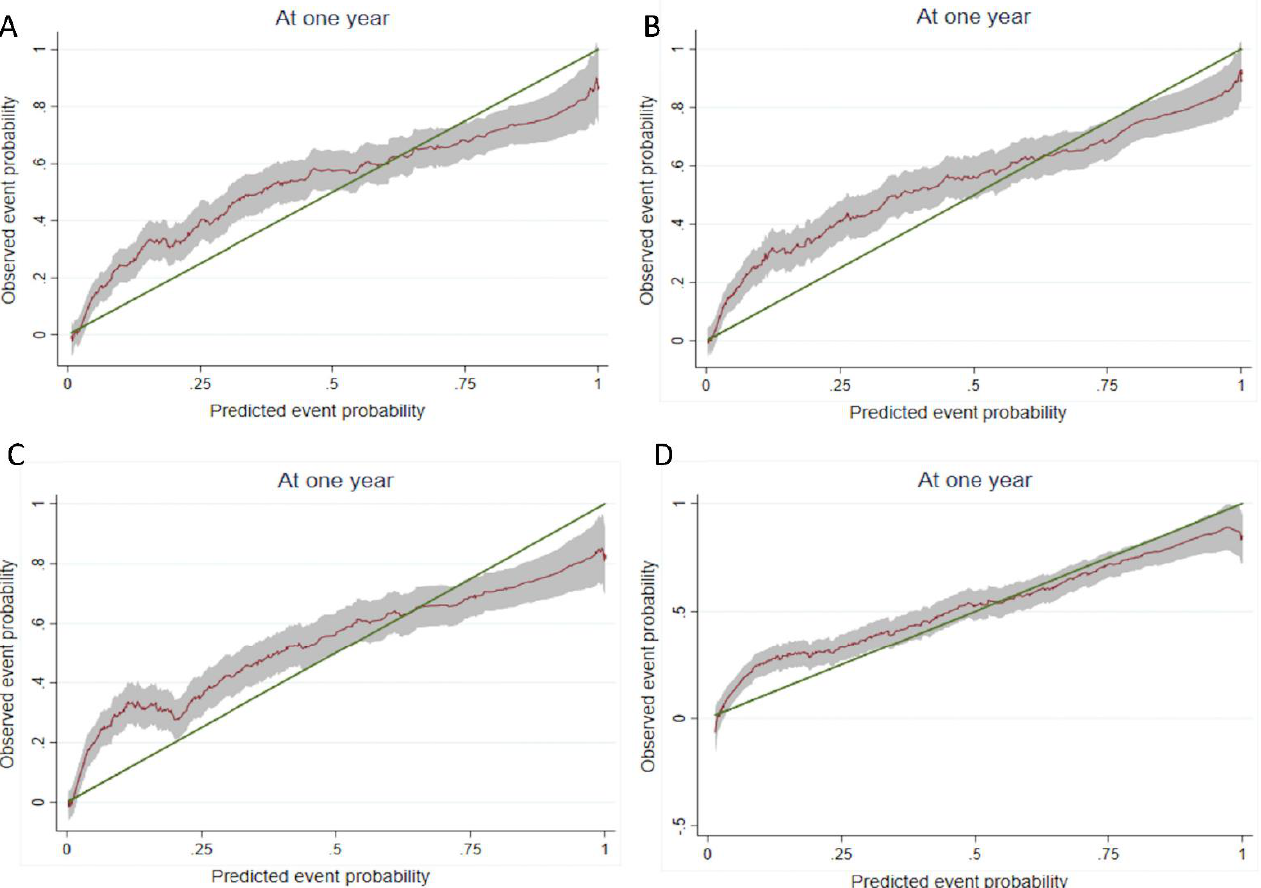
Figure 2. Calibration slopes for ( A ) the original CCI, ( B ) the Gagne index, ( C ) the ECI, and ( D ) the CIRS-G. Smoothed pseudovalues (red line) with 95% CI plotted against predicted event probabilities at one year. The green line is the line of identity, denoting perfect calibration. CCI indicates Charlson Comorbidity Index; ECi indicates Elixhauser-van Walraven Comorbidity Index; CIRG-S indicates Cumulative Illness Rating Scale for Geriatrics